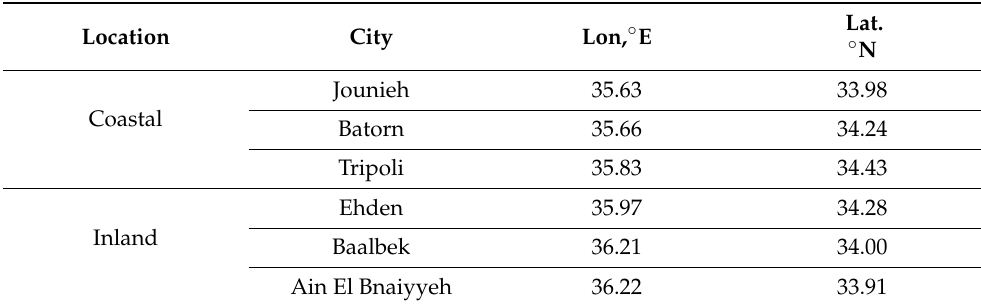
Table 1. Longitude and latitude of 3 coastal cities (Jounieh, Batron, and Tripoli) and 3 inland cities (Ehden, Baalbek, and Air El Bnaiyyeh in Lebanaon. Location